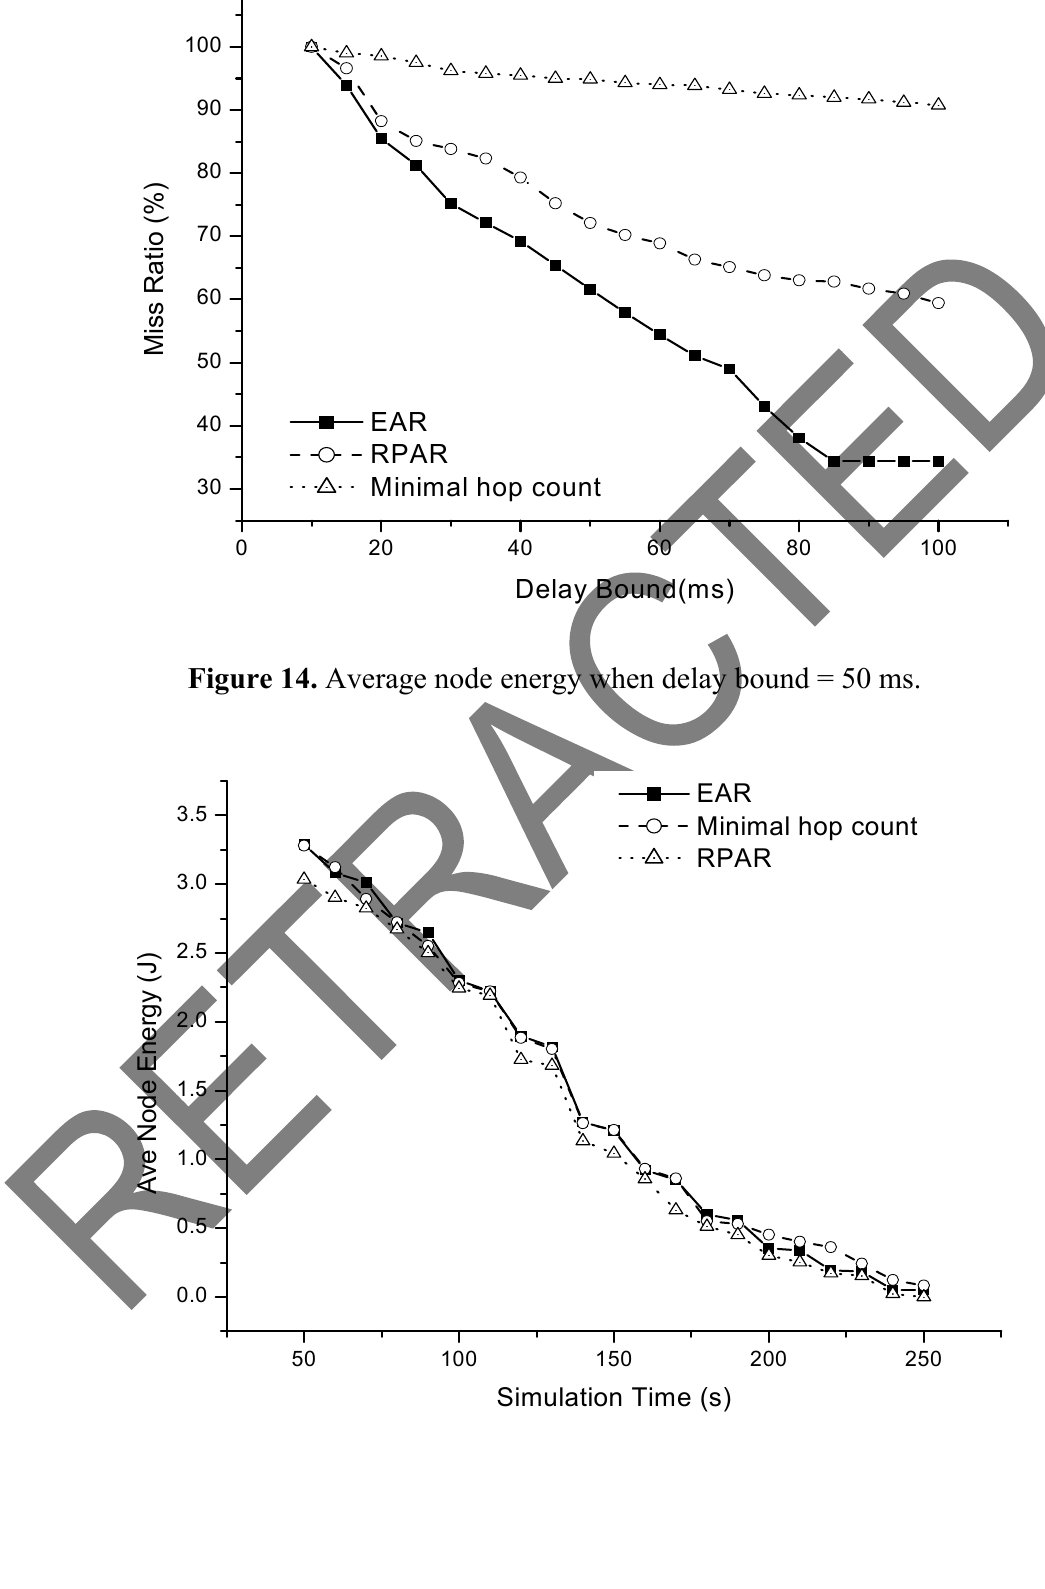
Figure 14. Average node energy when delay bound = 50